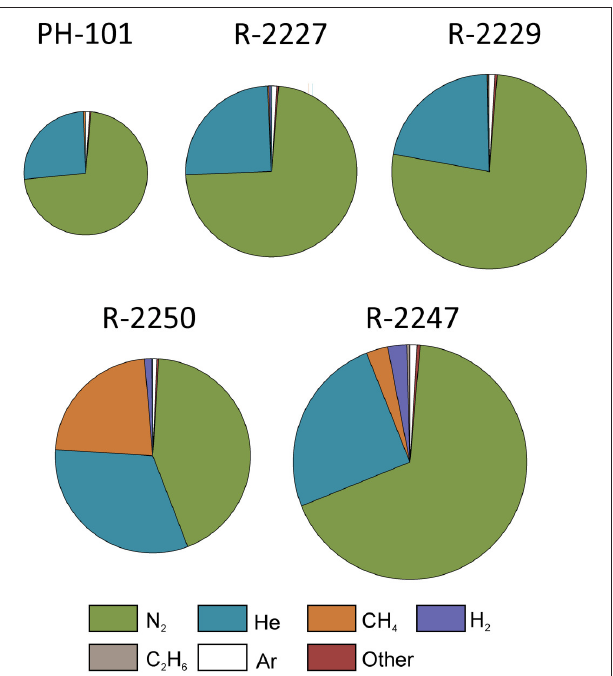
FIGURE 3 | Relative compositions of dissolved gases in the drill holes sampled in the Pyhäsalmi mine. Areas of the charts are proportional to the average gas volumes measured in each of the drill holes, with the largest chart (R-2247) corresponding to a gas volume of 90mL per 1L of groundwater. Other gases include O 2 , CO 2 , propane, butane, and pentane (Supplementary Table